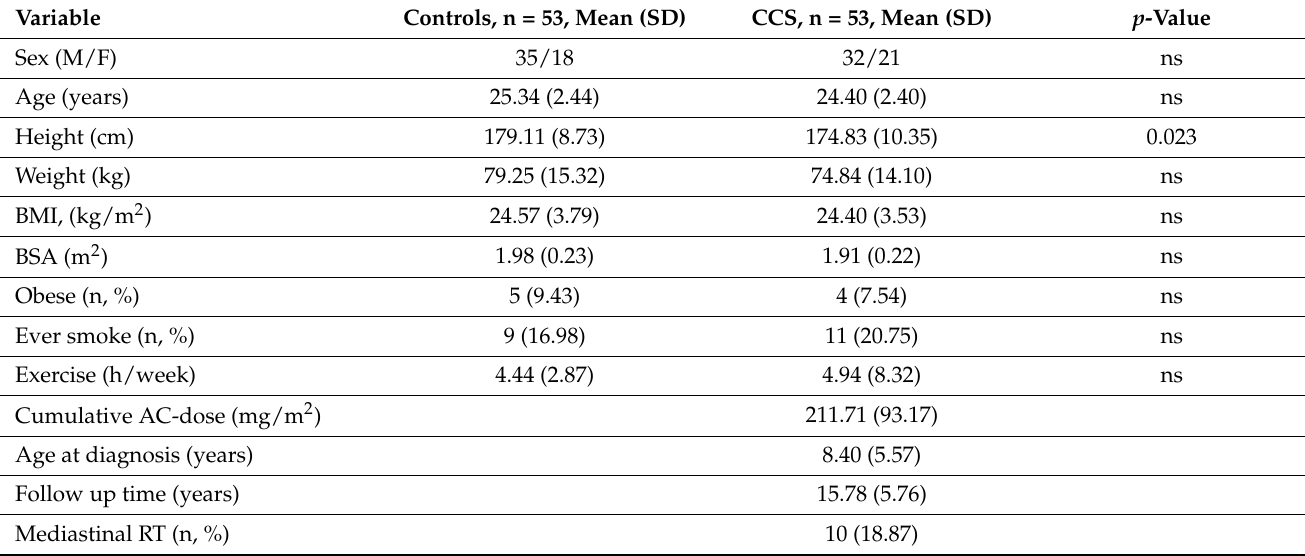
Table 1. Baseline Characteristics of CCS and Healthy